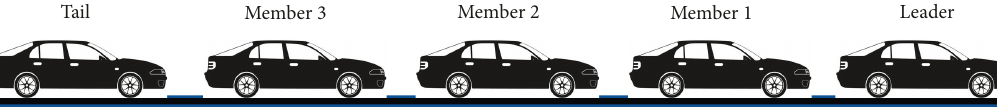
Figure 1: Vehicles operating in the